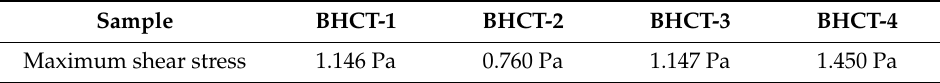
Table 6. Area of thixotropic ring of composite gel under di ff erent crosslinking agent